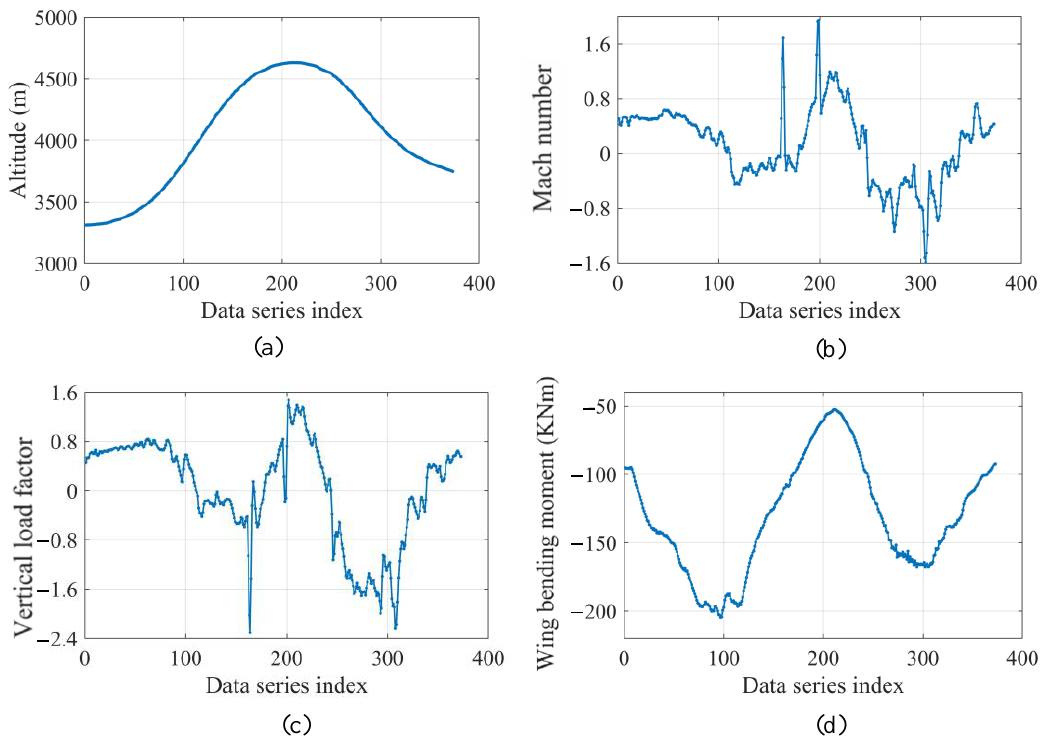
Figure 6. Demonstration of three flight parameters and wing bending moment of typical loop maneuver: ( a ) altitude, ( b ) Mach number, ( c ) vertical load factor, and ( d ) wing bending moment.